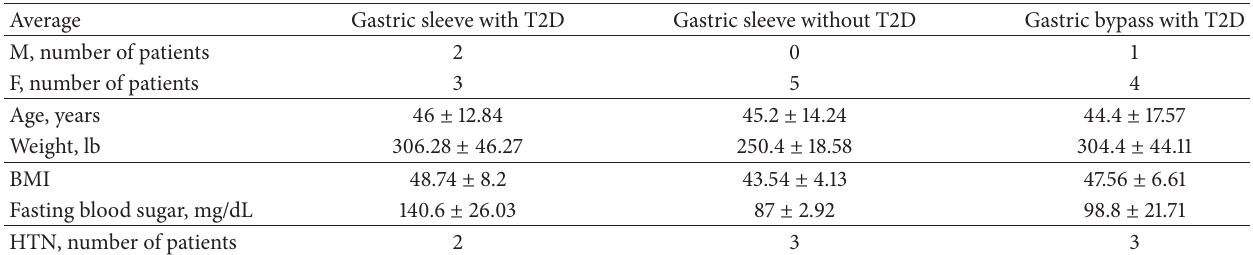
Table 1: Clinicopathological characteristics of the